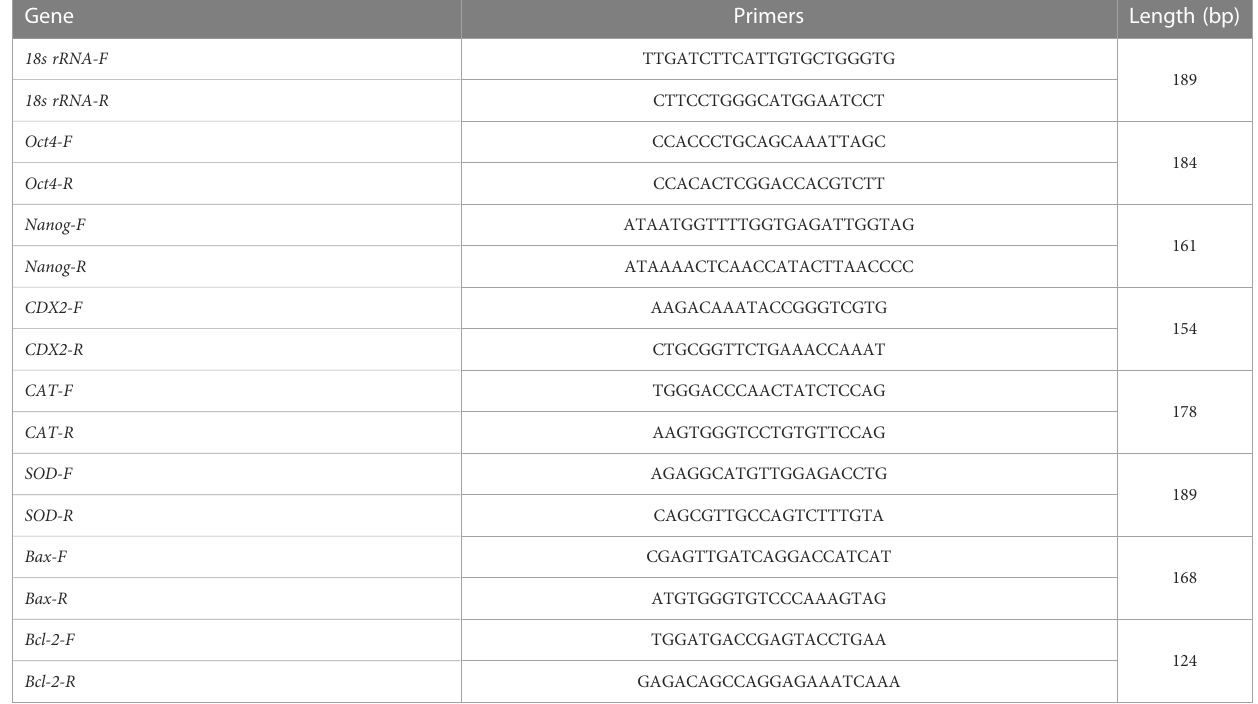
TABLE 2 Primer sequences for real-time